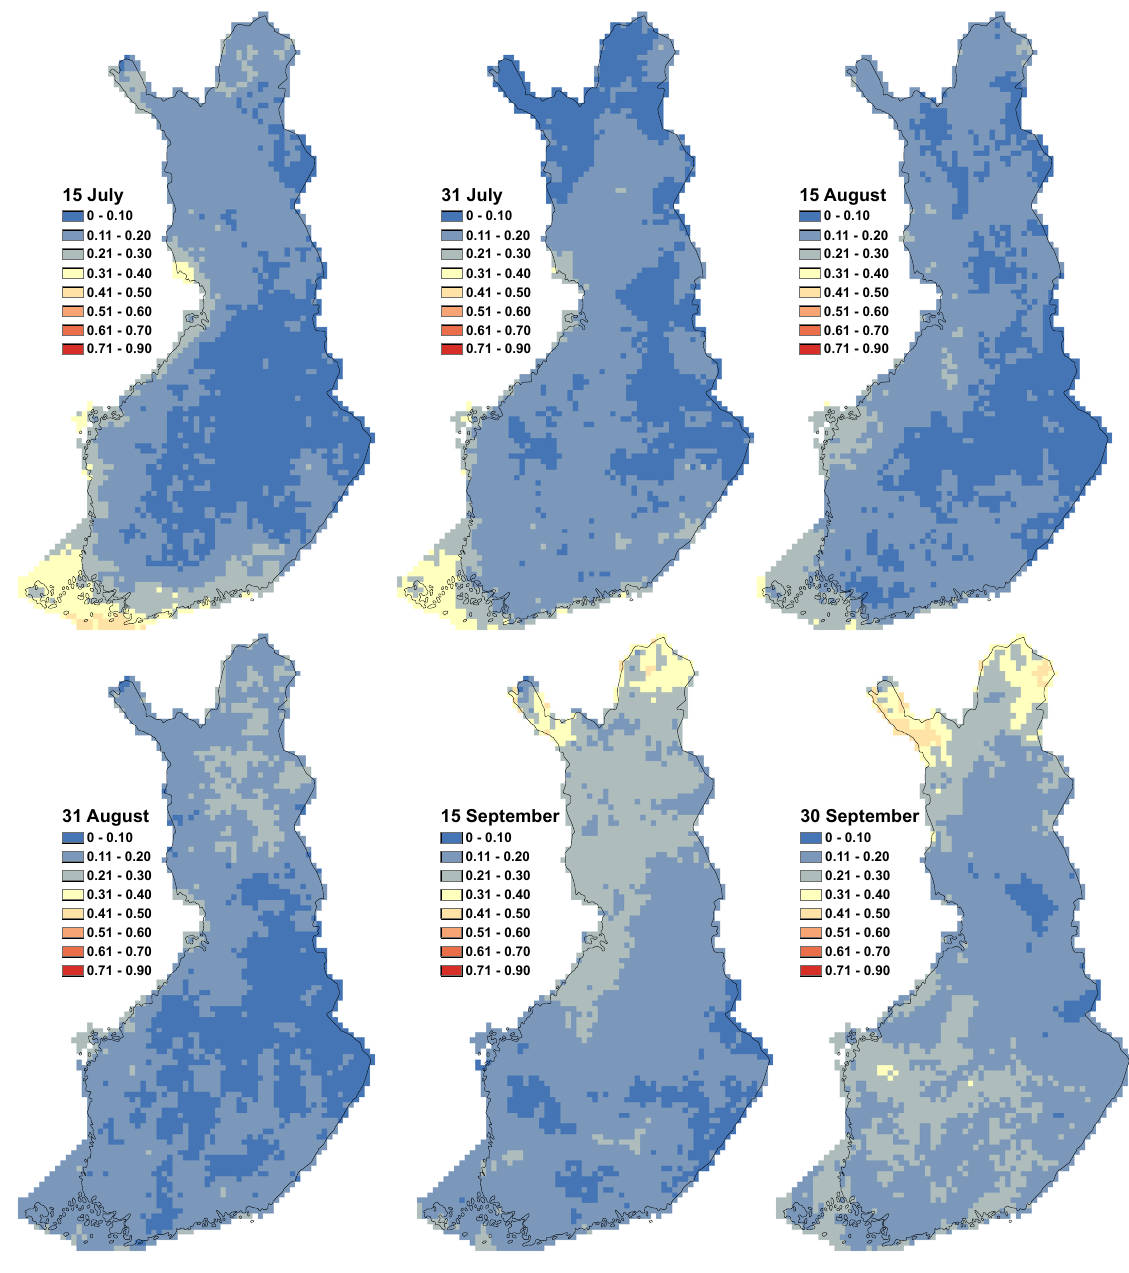
Fig. 2b. Probabilities of drought lasting for at least three weeks for the periods that ended on 15 July to 30